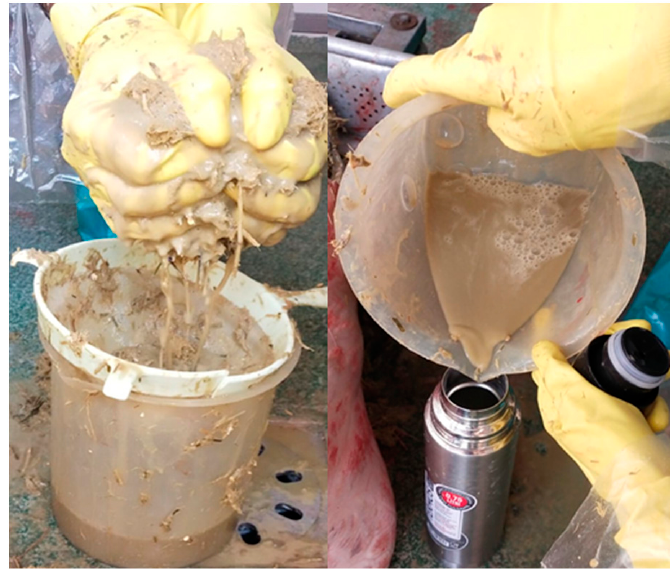
Figure 1. Sectioning of the rumen.